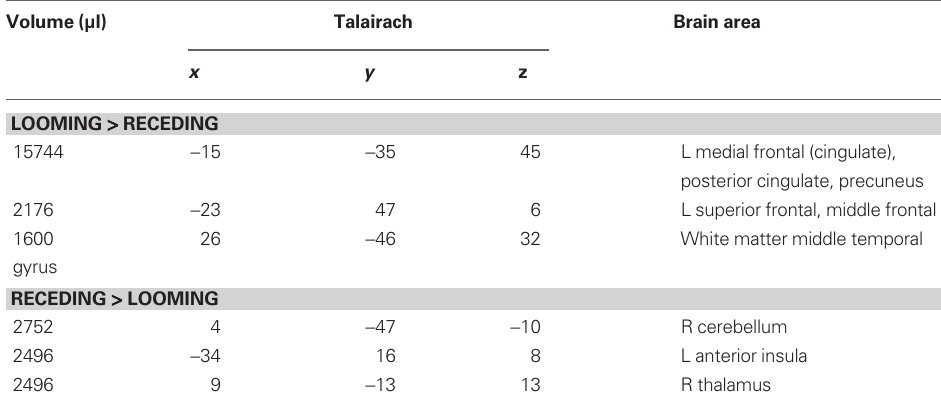
Table 3 | LOOM > ReCeDe, ReCeDe > LOOM. Regions of significant activation ( P < 0.05, corrected) for the contrast looming > receding disc and receding > looming disc.